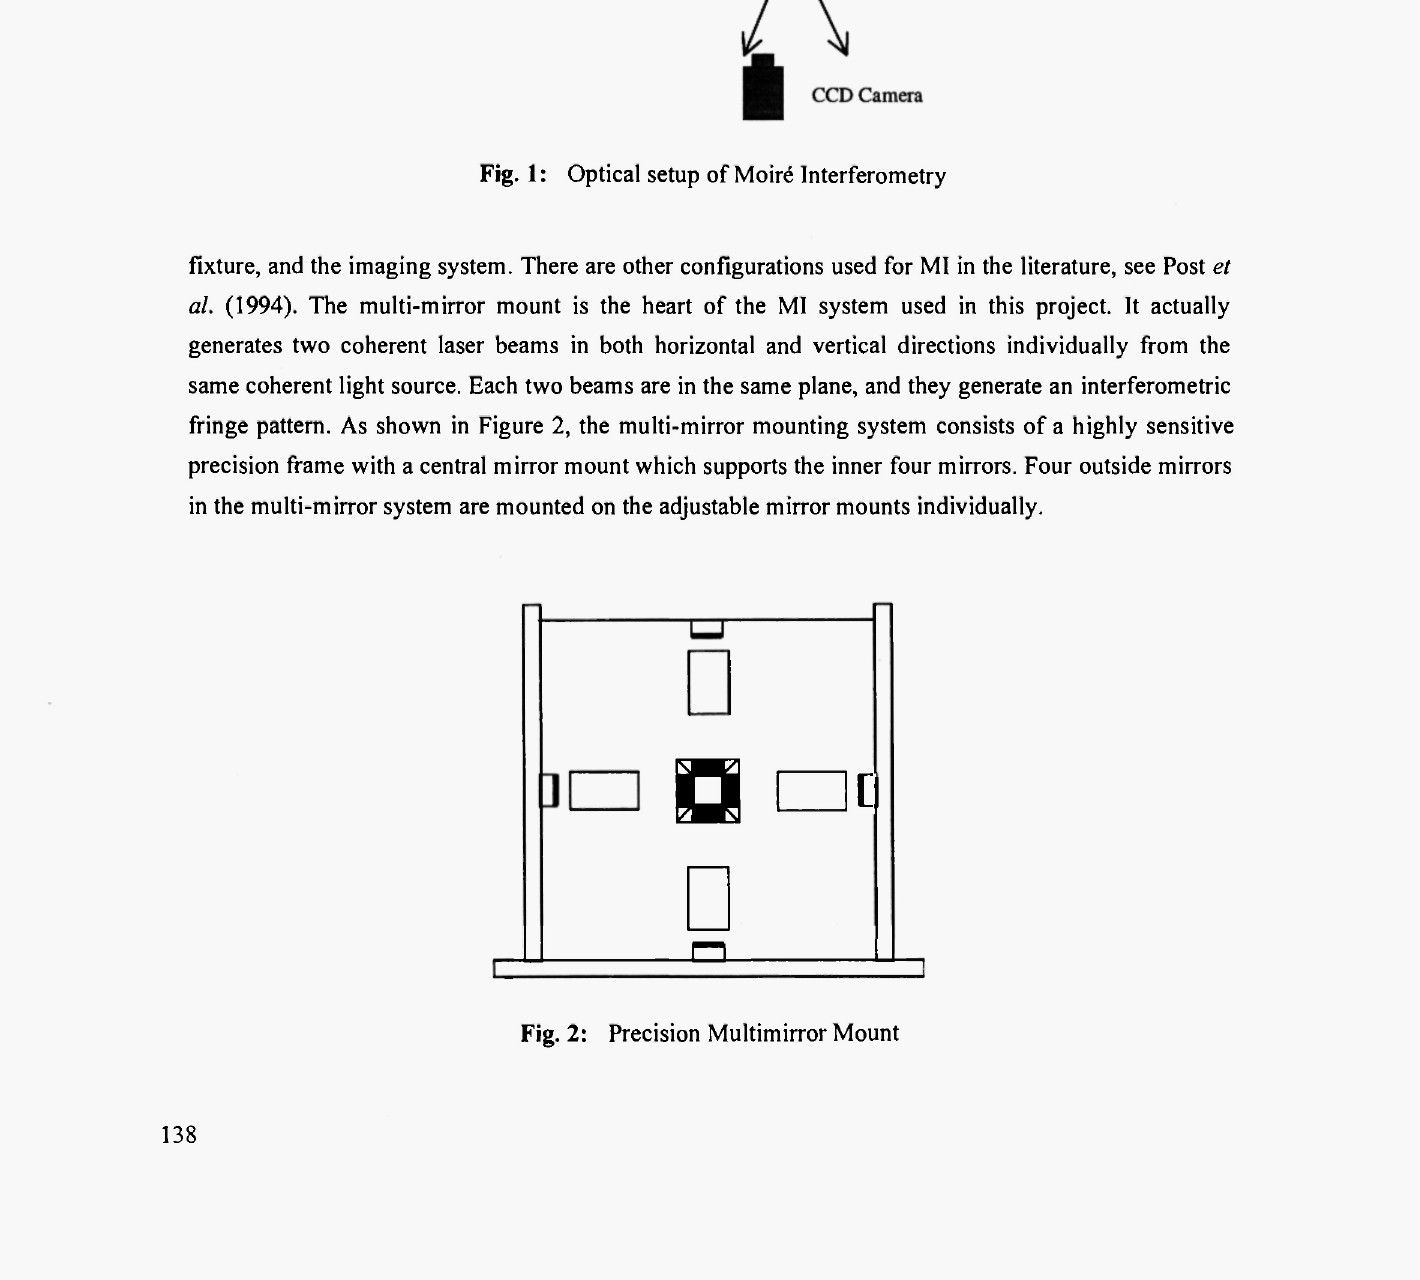
Fig. 1: Optical setup of Moir£